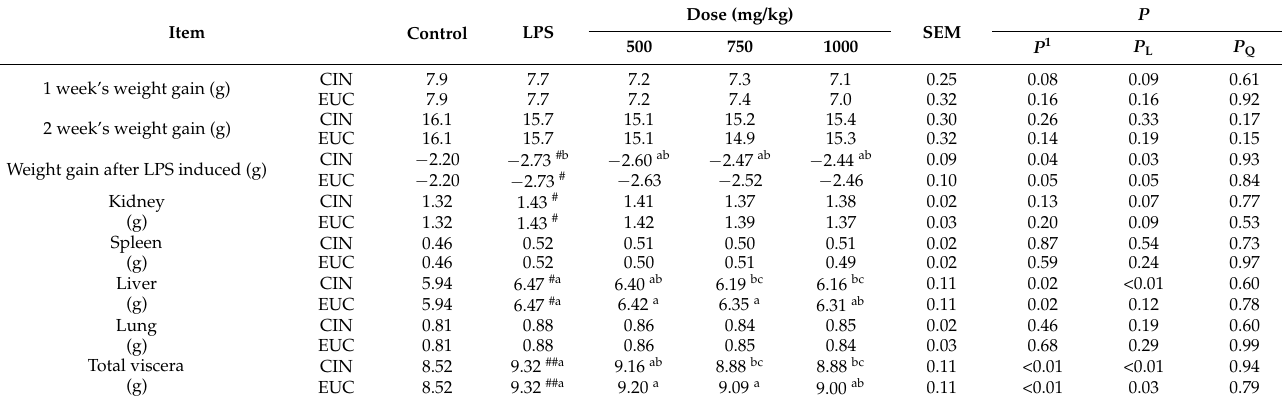
Table 2. Effects of EOs on weight and viscera of mice induced by